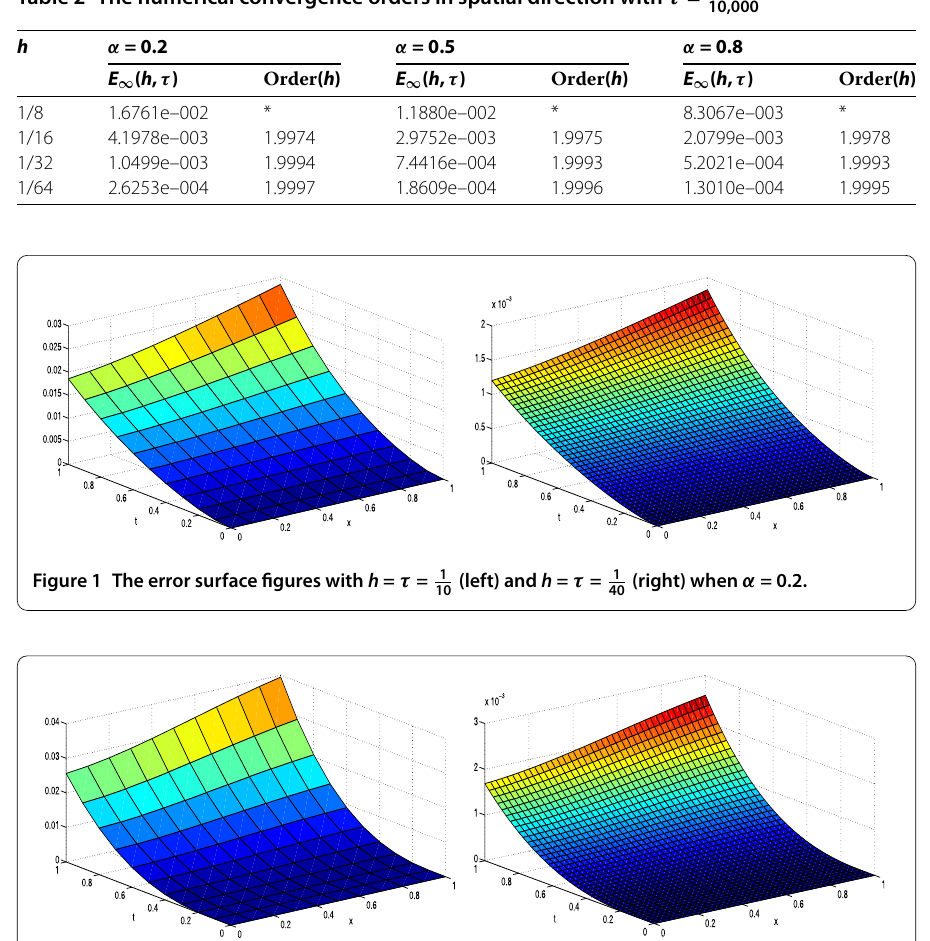
(left) and h = τ = 1 (right) when α = 10 40